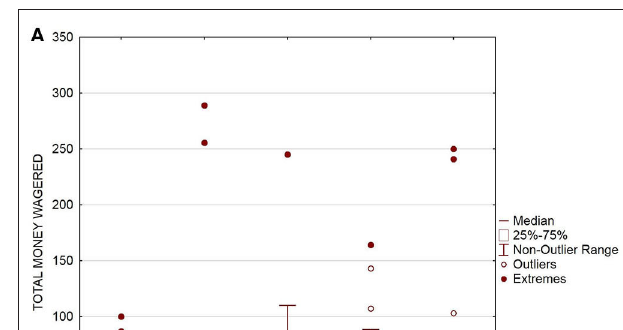
(13.53%), or an excellent (1.76%) opinion of the operator if he/she would implement the limitation of wagering inducements.